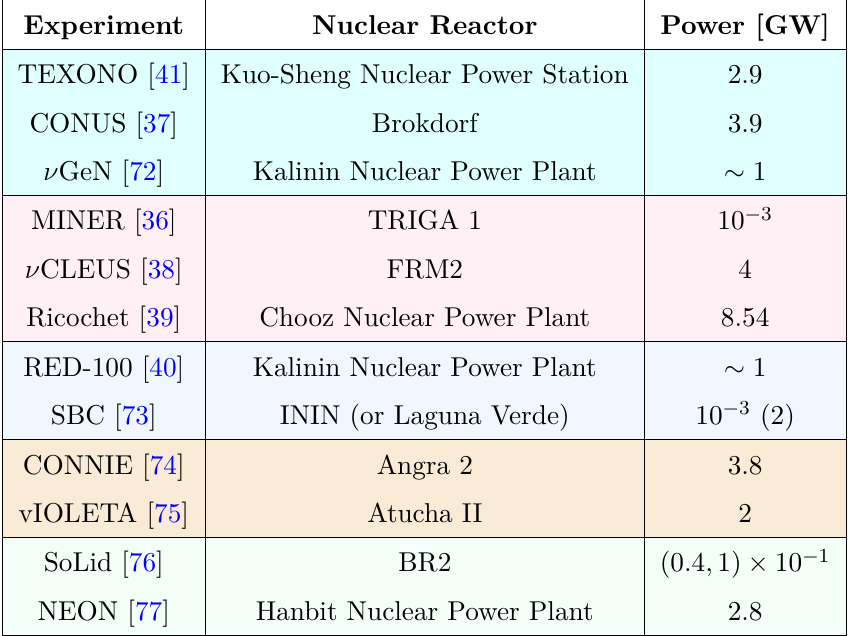
Table 1 . Reactor neutrino experiments to which our analysis may apply. We also present the associated nuclear reactor along with its thermal power. The color codes are associated with the detection techniques the experiments rely on as specified in table 3.